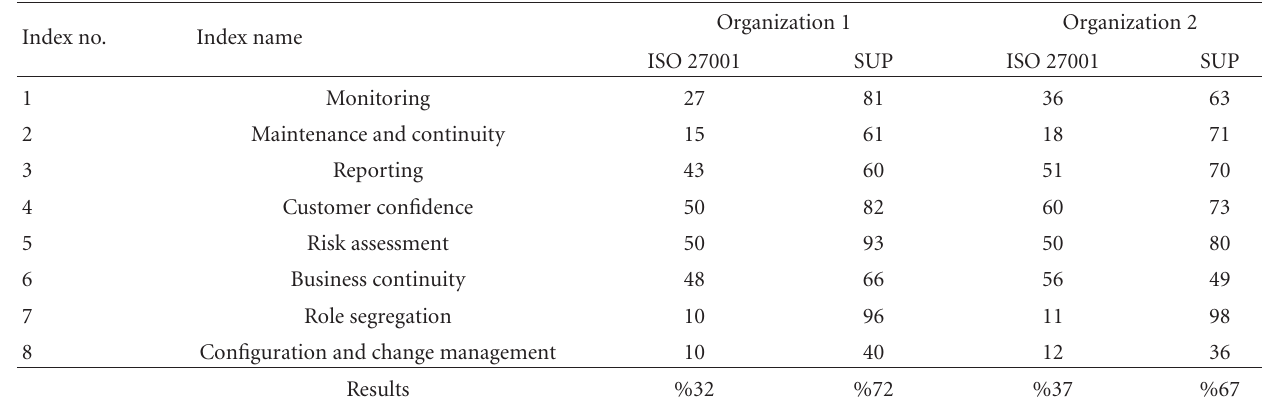
Table 16: The comparison between the two